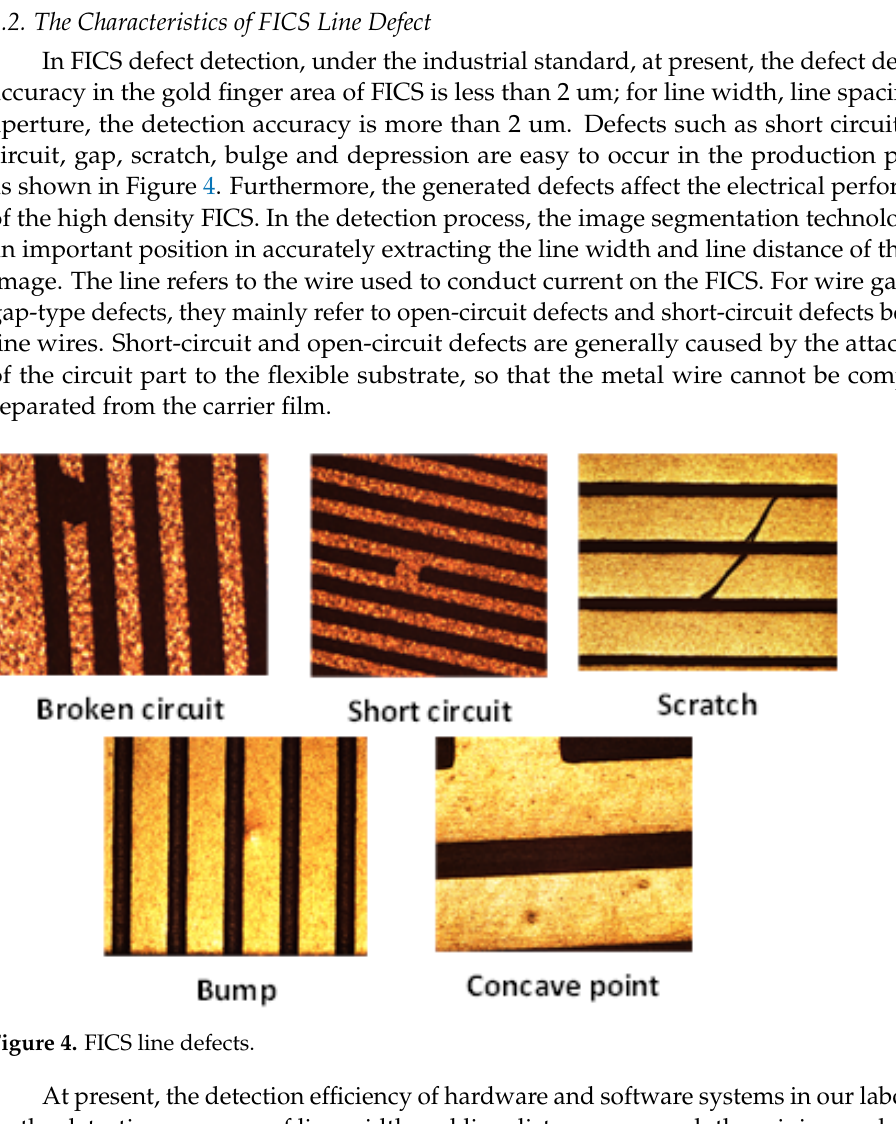
Figure 3. Comparison of the collection effect of the same type of substrate under different types of light sources.